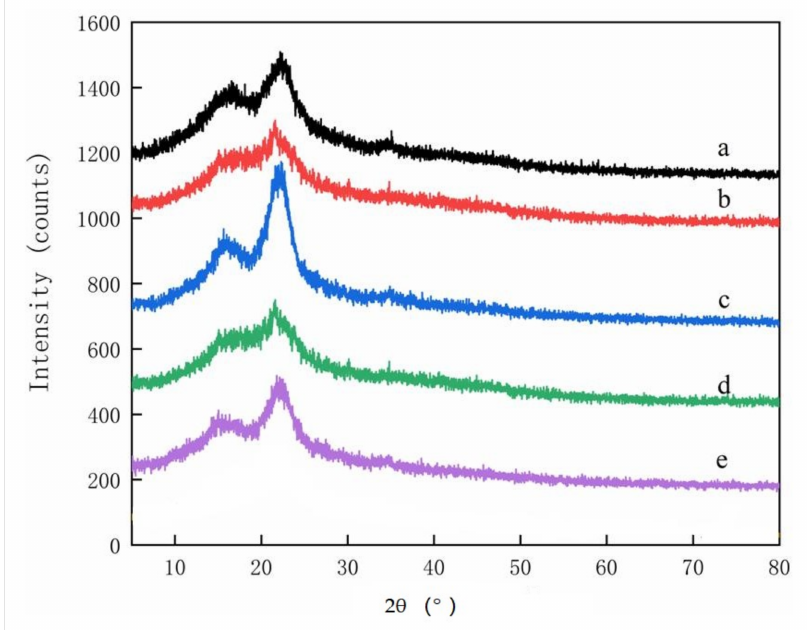
Figure 4. XRD spectra of parent materials used to produce CMCs: ( a ) pine wood, ( b ) bamboo culm, ( c ) pine needles, ( d ), bamboo leaves, or ( e ) hemp